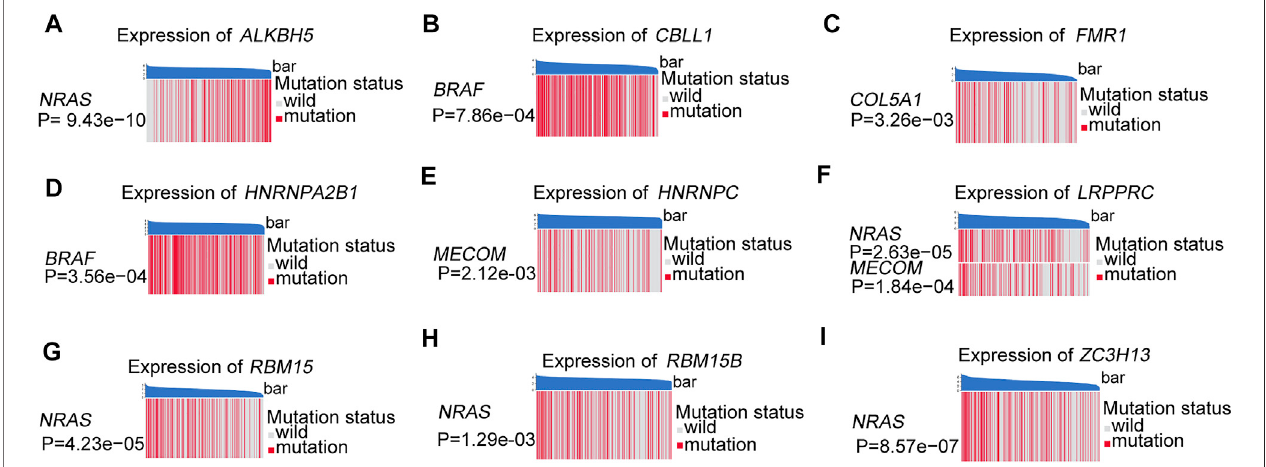
FIGURE 3 | These heatmaps were used to visualize the expression of m6A regulators between the driver genes mutant and wild samples, permutation test, p < 0.005. (A) ALKBH5 between the different mutation statuses of NRAS . (B) CBLL1 between the different mutation statuses of BRAF . (C) FMR1 between the different mutationstatusesof COL5A1 . (D) HNRNPA2B1 betweenthedifferentmutationstatusesof BRAF . (E) HNRNPC betweenthedifferentmutationstatusesof MECOM . (F) LRPPRC between the different mutation statuses of NRAS and MECOM . (G) RBM15 between the different mutation statuses of NRAS . (H) RBM15B between the different mutation statuses of NRAS . (I) ZC3H13 between the different mutation statuses of NRAS .